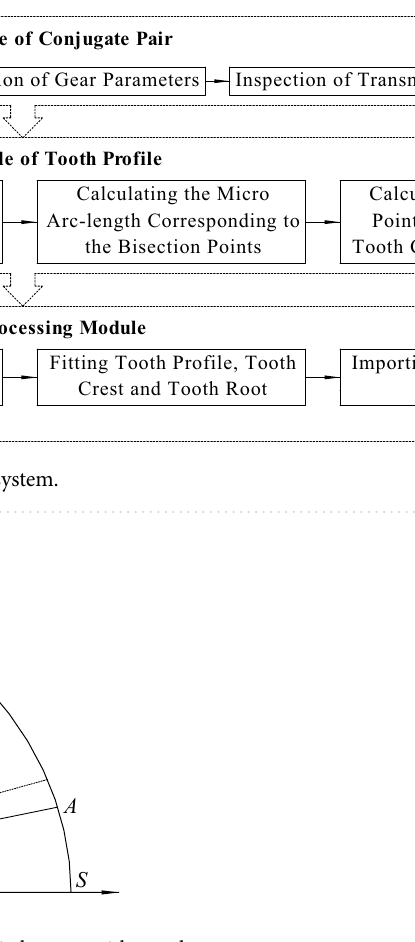
Figure 3. Structure diagram of dividing pitch curve with equal